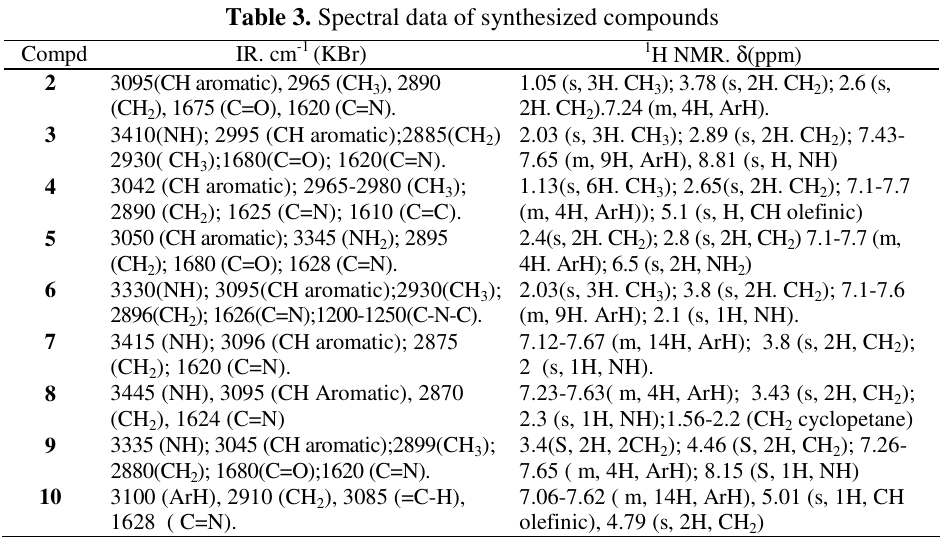
Table 3. Spectral data of synthesized